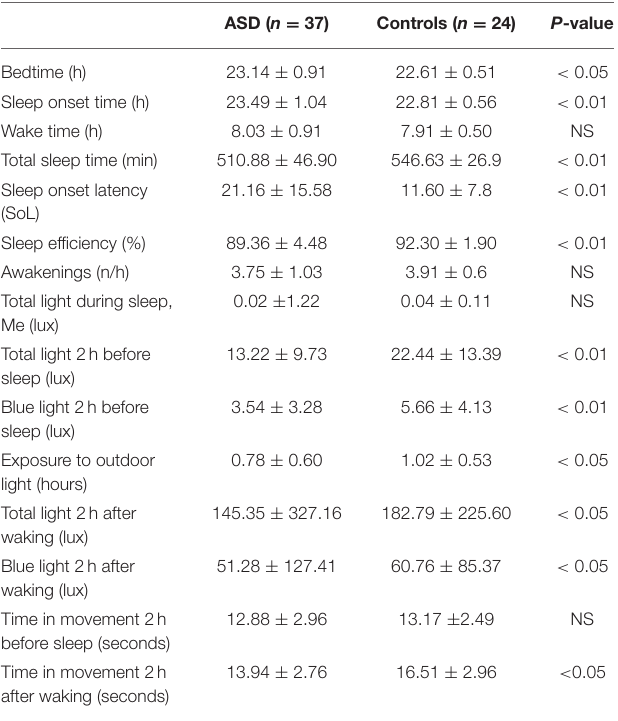
TABLE 3 | Description of sleep parameters (median and standard deviation) and a comparison analysis between the ASD and control